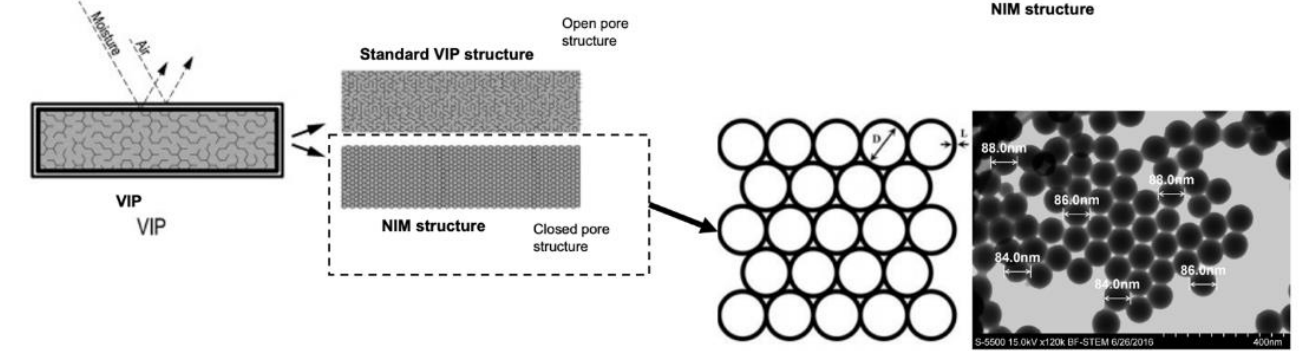
Figure 7. Comparison of the structure of a vacuum insulation panel (VIP) and nano-insulation material (NIM). Source: modified from [217–219].